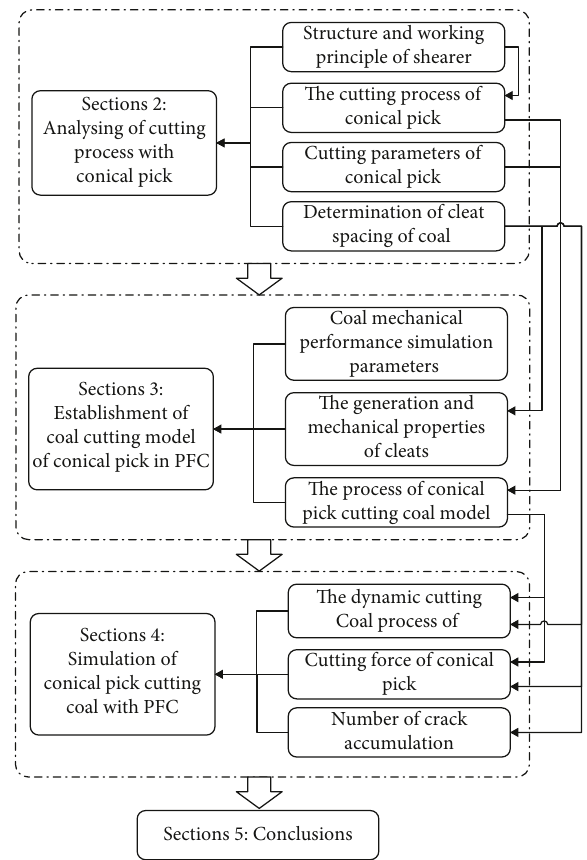
Figure 1: The detailed treatment method and process of the whole paper.